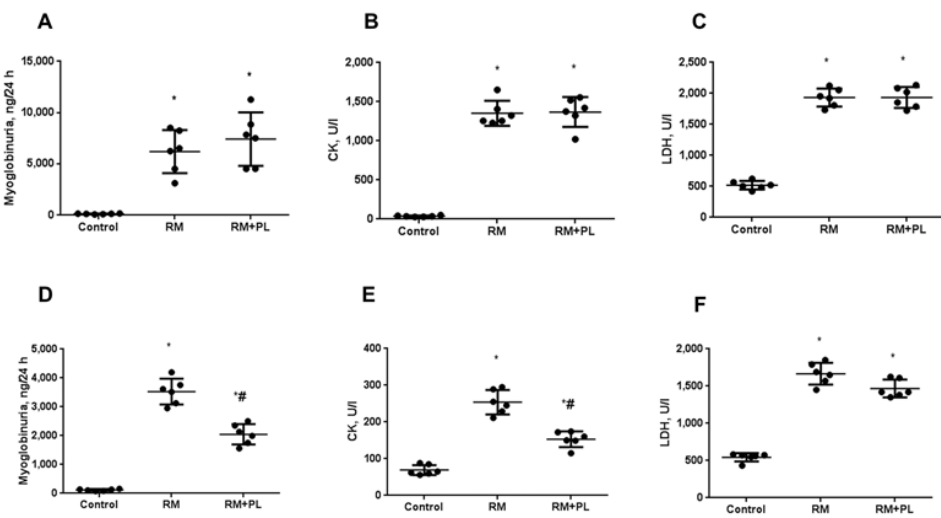
Figure 4. Analysis of muscle damage markers in the urine and serum of rats with rhabdomyolysis and after PL administration. Glycerol-induced rise in urinary myoglobin ( A ), serum CK ( B ), and LDH ( C ) after 24 h. The same parameters after 7 days ( D – F ). * p < 0.05 compared to control, # p < 0.05 compared to RM.